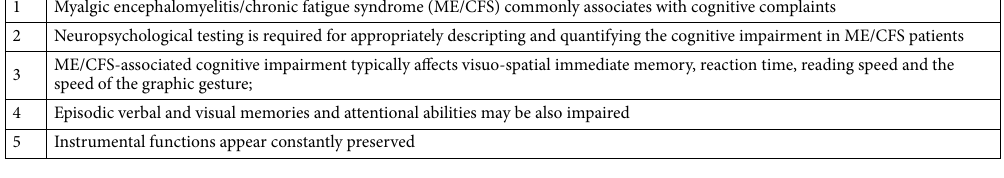
Table 12. Take home